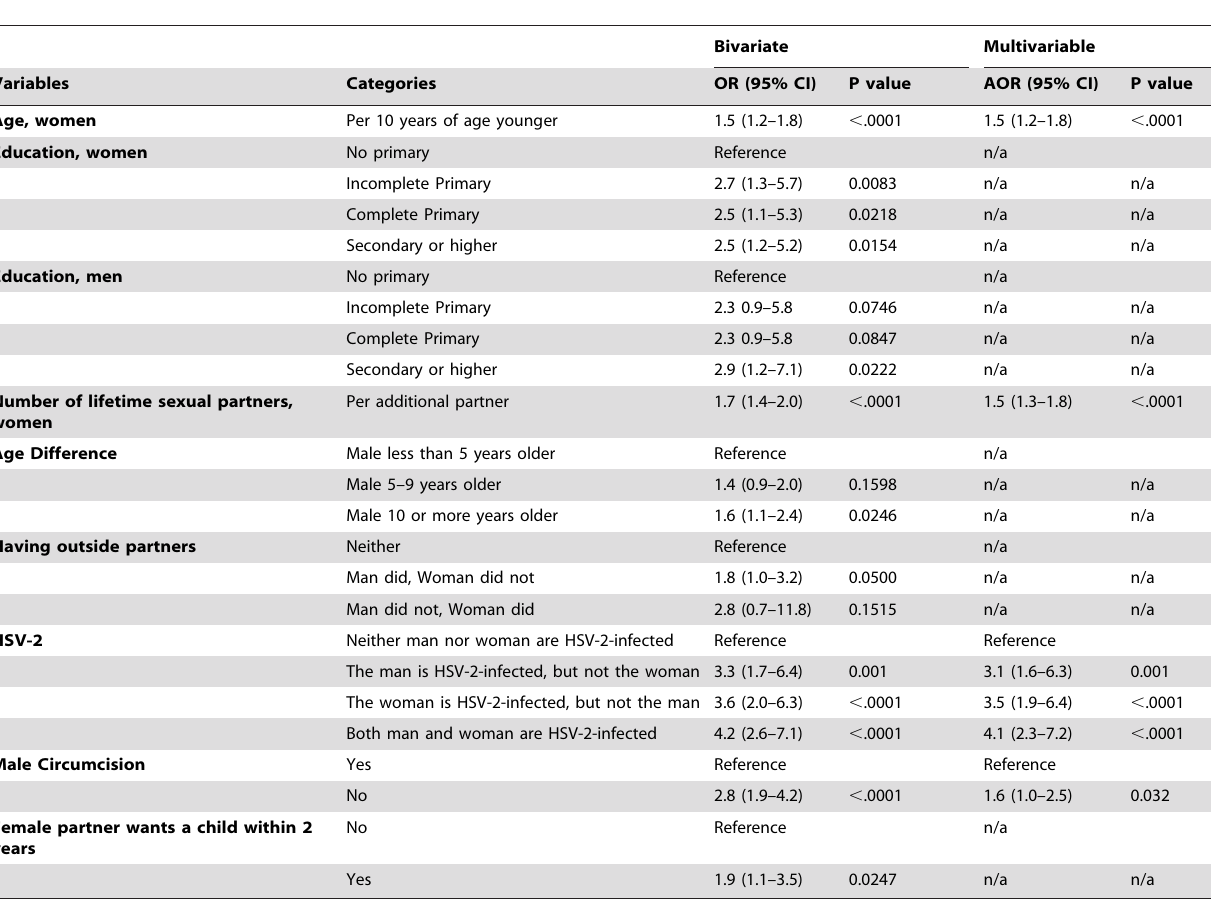
Table 2. Unadjusted* and adjusted odds ratios for factors associated with HIV discordance vs. HIV uninfected concordance, Kenya AIDS Indicator Survey 2007.